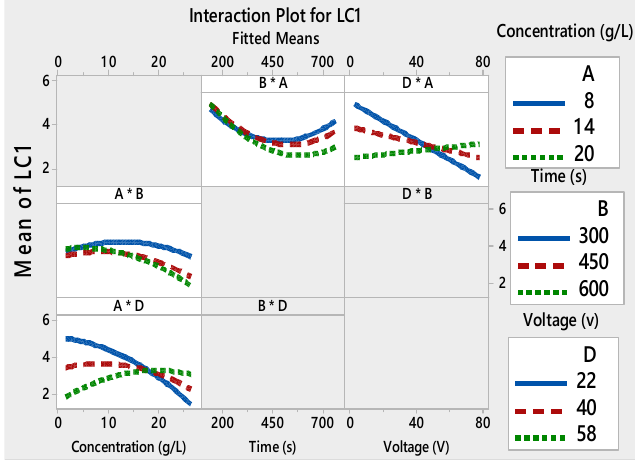
Figure 4. Interaction plots for L C1 ((*) refers to multiplication sign (×)).